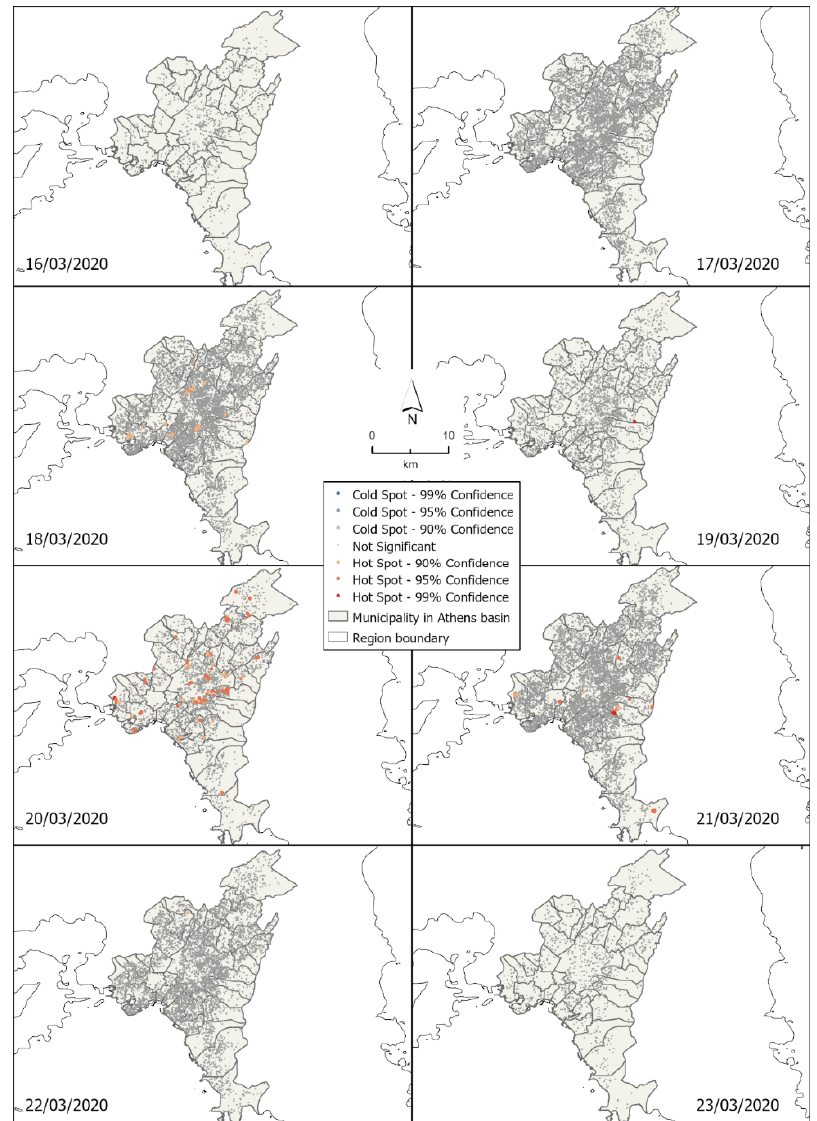
Figure 7. Hot spot analysis for Athens metropolitan area and surrounding towns on daily basis for the first eight days of the survey.